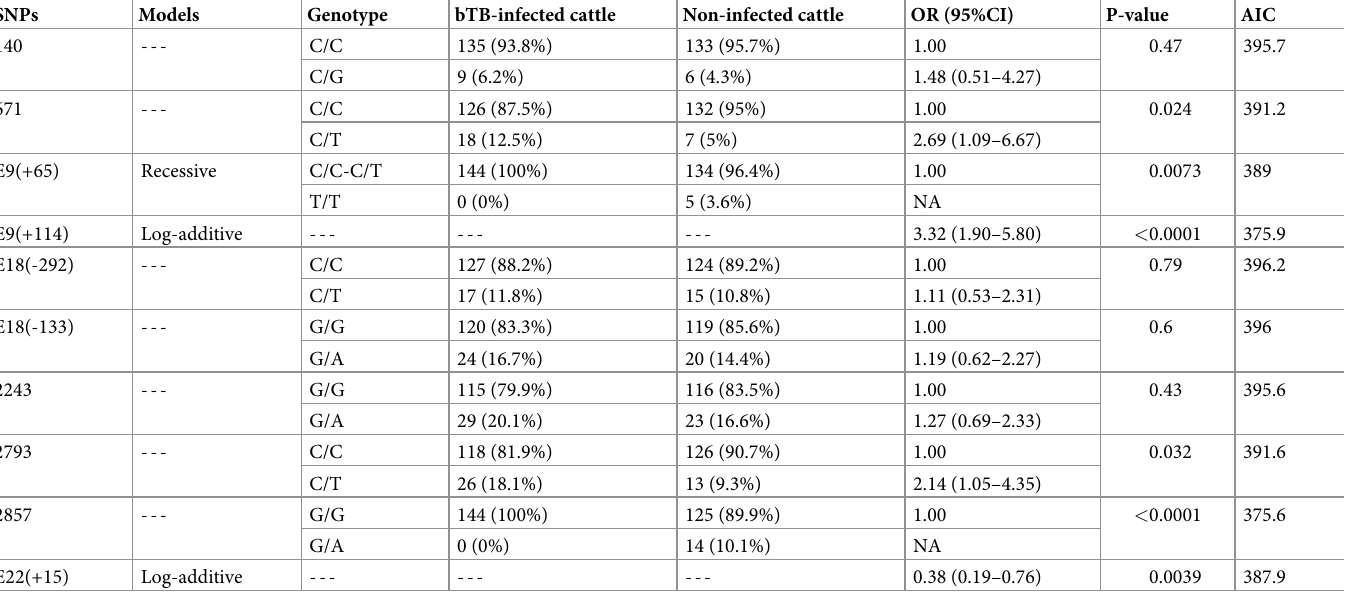
Table 4. Association analysis between SNP sites and tuberculosis infection in cattle.